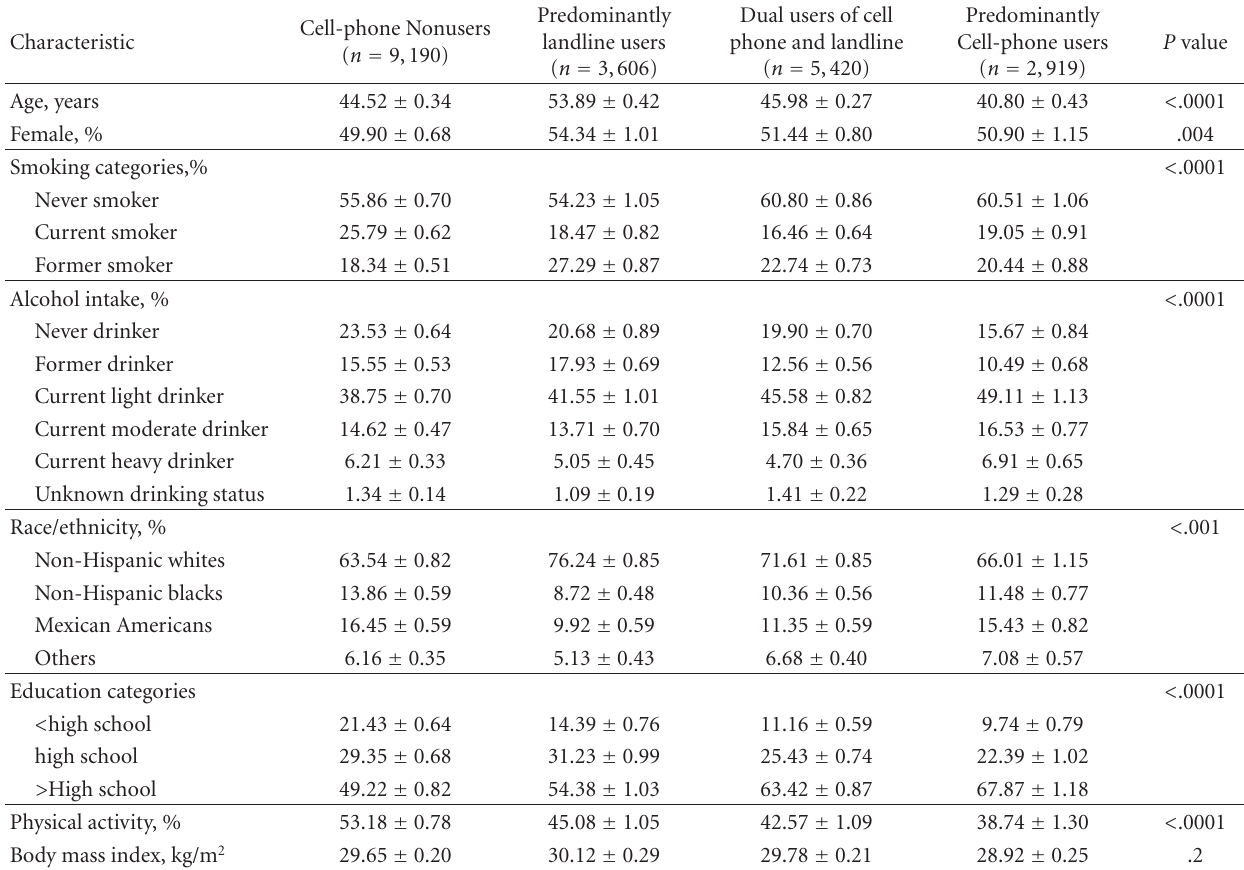
Table 1: Characteristics of the participants by cell-phone use.